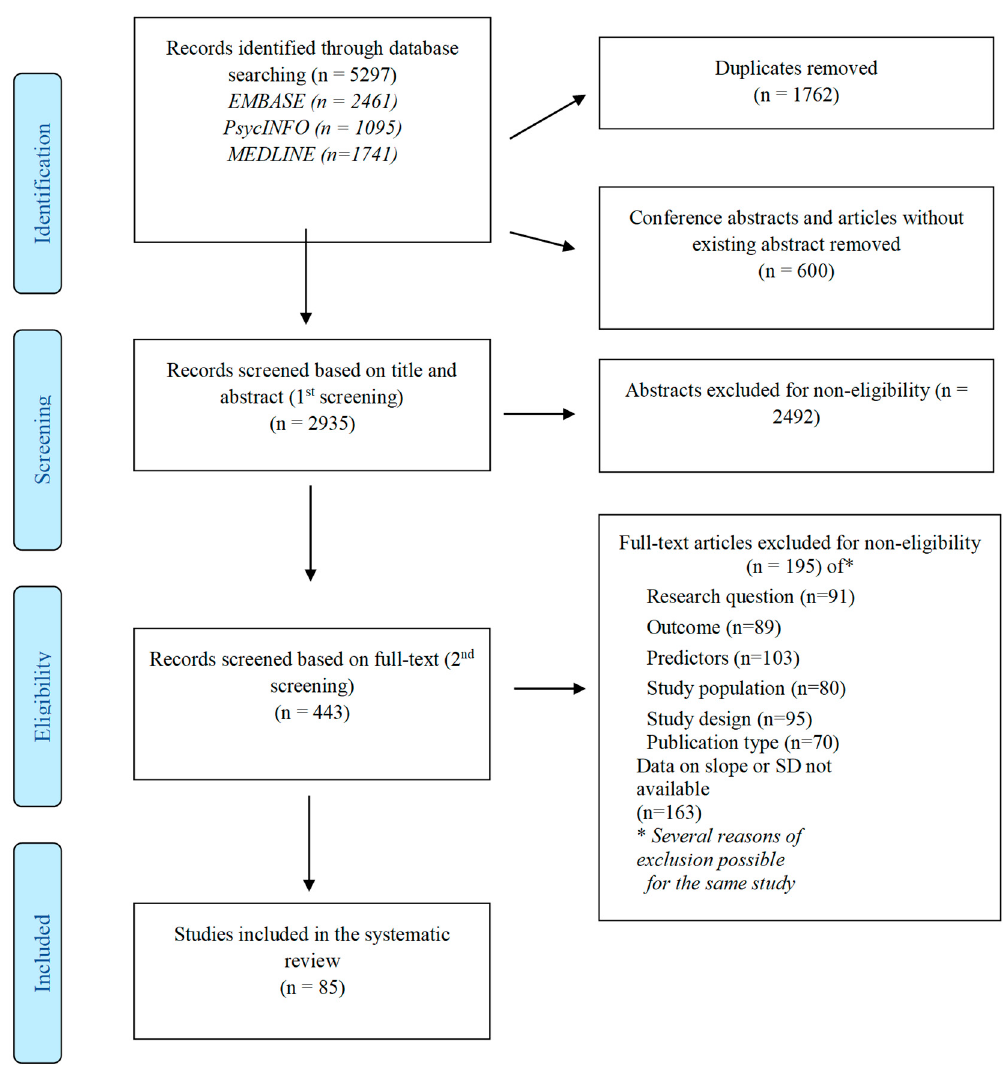
Figure 2. Flow-chart of the included studies.